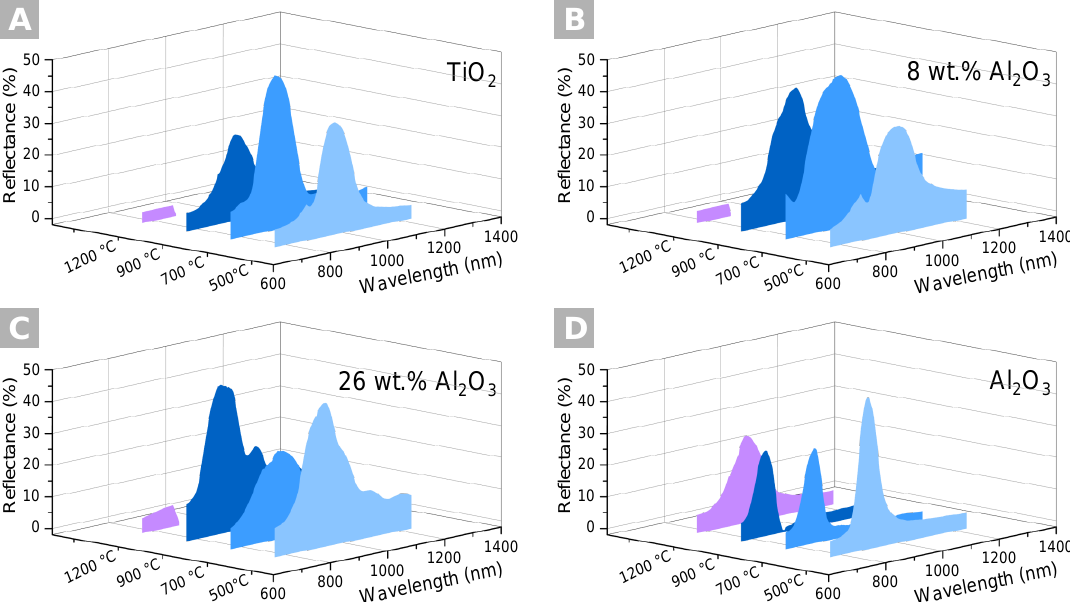
Figure 6. Specular reflectance of inverse photonic crystals according to the heat treatment temperature (500 to 1200 °C) for different materials: ( a ) TiO 2 ( b ) TiO 2 with 8 wt.% Al 2 O 3 ( c ) TiO 2 with 26% wt.% Al 2 O 3 ( d ) Al 2 O 3 . The break observed in the data points at around 889 nm of wavelength is related to a mechanical change in the monochromator set up of the UV–Vis equipment.